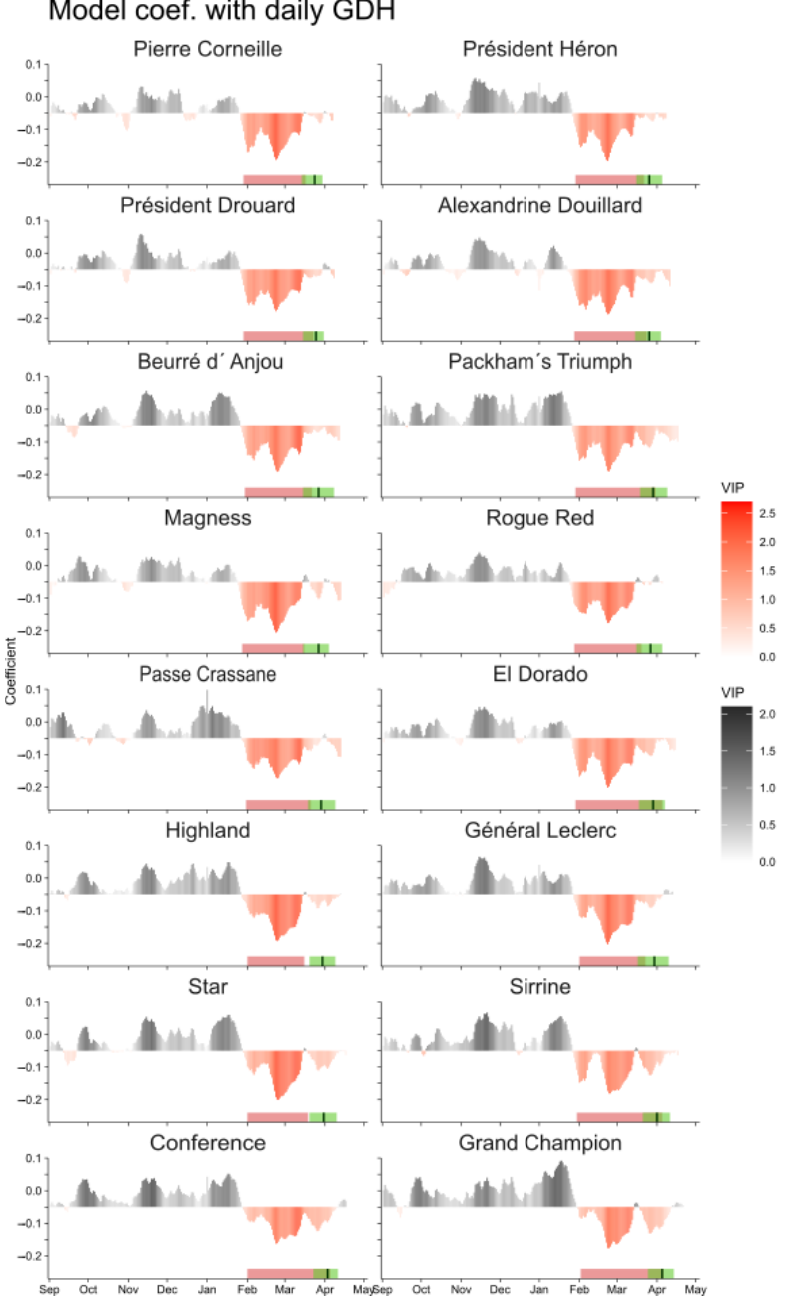
Figure 3. Partial Least Squares regression analysis between flowering dates of 16 cultivars of pear grown in Zaragoza (northeastern Spain) and daily accumulations of heat in Growing Degree Hours (GDH). The direction of the vertical bars in each plot indicates days with positive or negative model coef-ficients, and the color of the bar represents the variable importance in the projection (VIP) score (with red for negative coefficients and gray for positive). Horizontal thick bars at the bottom of each plot indicate the delineated forcing periods (red) and the range of observed flowering dates (green). In the bars showing the flowering range, the dark purple vertical line indicates the median flow-ering date in the 20 years